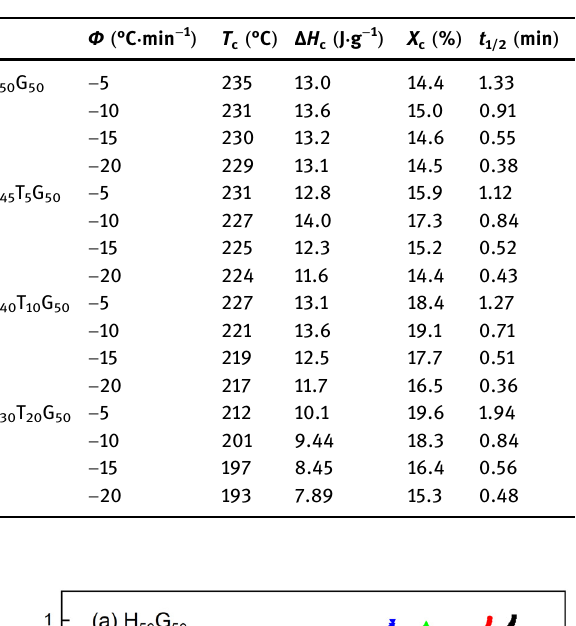
Table 3: DSC results derived from the scans at the cooling rates of − 5, − 10, − 15, and − 20°C · min − 1 for H 50 G 50 ( a ) , H 45 T 5 G 50 ( b ) , H 40 T 10 G 50 ( c ) , and H 30 T 20 G 50 ( d ) , respectively